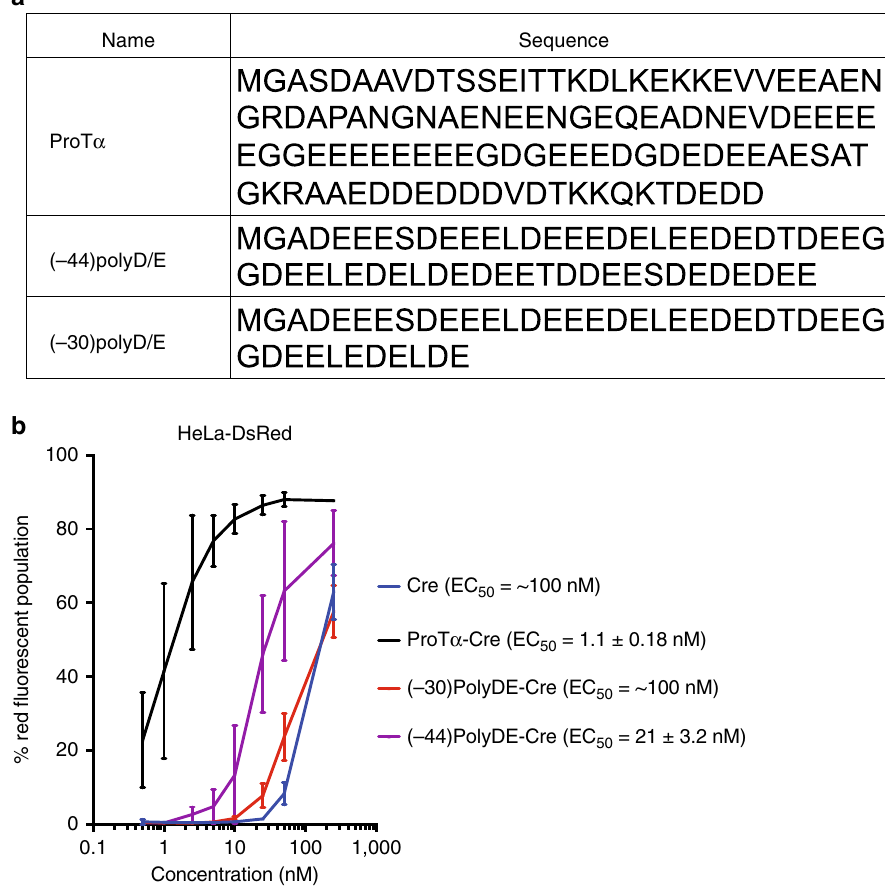
Fig. 2 ProT α delivery potency cannot be recapitulated by simple oligomers of acidic residues. a Sequences of ProT α and charged peptide analogs that contain – 30 or – 44 net theoretical charge for comparison. All proteins contain a Gly-Ala inserted after the initial Met to minimize expression level differences. b Despite sharing the same net theoretical charge as that of ProT α , ( − 44)PolyD/E-Cre does not promote potent protein delivery. EC 50 is de fi ned as the protein concentration at which 50% of analyzed HeLa-DsRed cells contain red fl uorescence. Values and error bars represent the mean and standard deviation of three independent biological replicates performed on different days. EC 50 values were determined by nonlinear fi t to the Hill equation, and are followed by the standard errors of the fi t. Source data are available in the Source Data fi